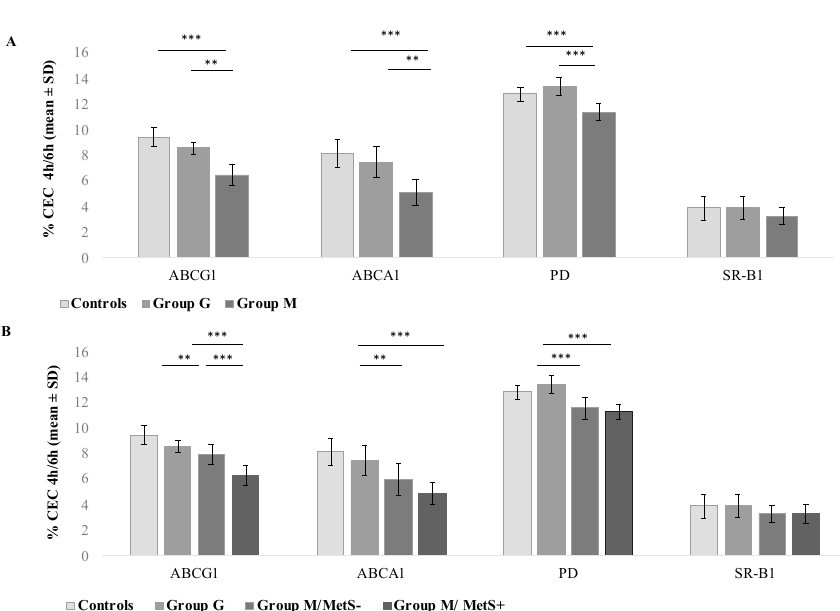
Figure 2. ABCG1-, ABCA1-, PD-, and SR-BI- mediated CEC according to NAFLD classification and MetS diagnosis. ( A ) shows differences in ABCA1-, ABCG1-, SR-BI- and PD-mediated CEC according to NAFLD classification; ( B ) shows differences in ABCA1-, ABCG1-, SR-BI-, and PD-mediated CEC according to the presence of MetS. Cholesterol efflux capacities expressed in relative efflux are presented in mean ± SD. *** for p < 0.0001; ** for p ≤ 0.002. ABCA1 indicates ATP binding cassette A1; ABCG1, ATP binding cassette subfamily G member 1; Group M, metabolic NAFLD group; Group G, genetic NAFLD group; Group M/MetS − , metabolic NAFLD group without MetS diagnosis; Group M/Mets+, metabolic NAFLD group with MetS diagnosis (see Section 2); SR-BI, scavenger receptor class B member 1.